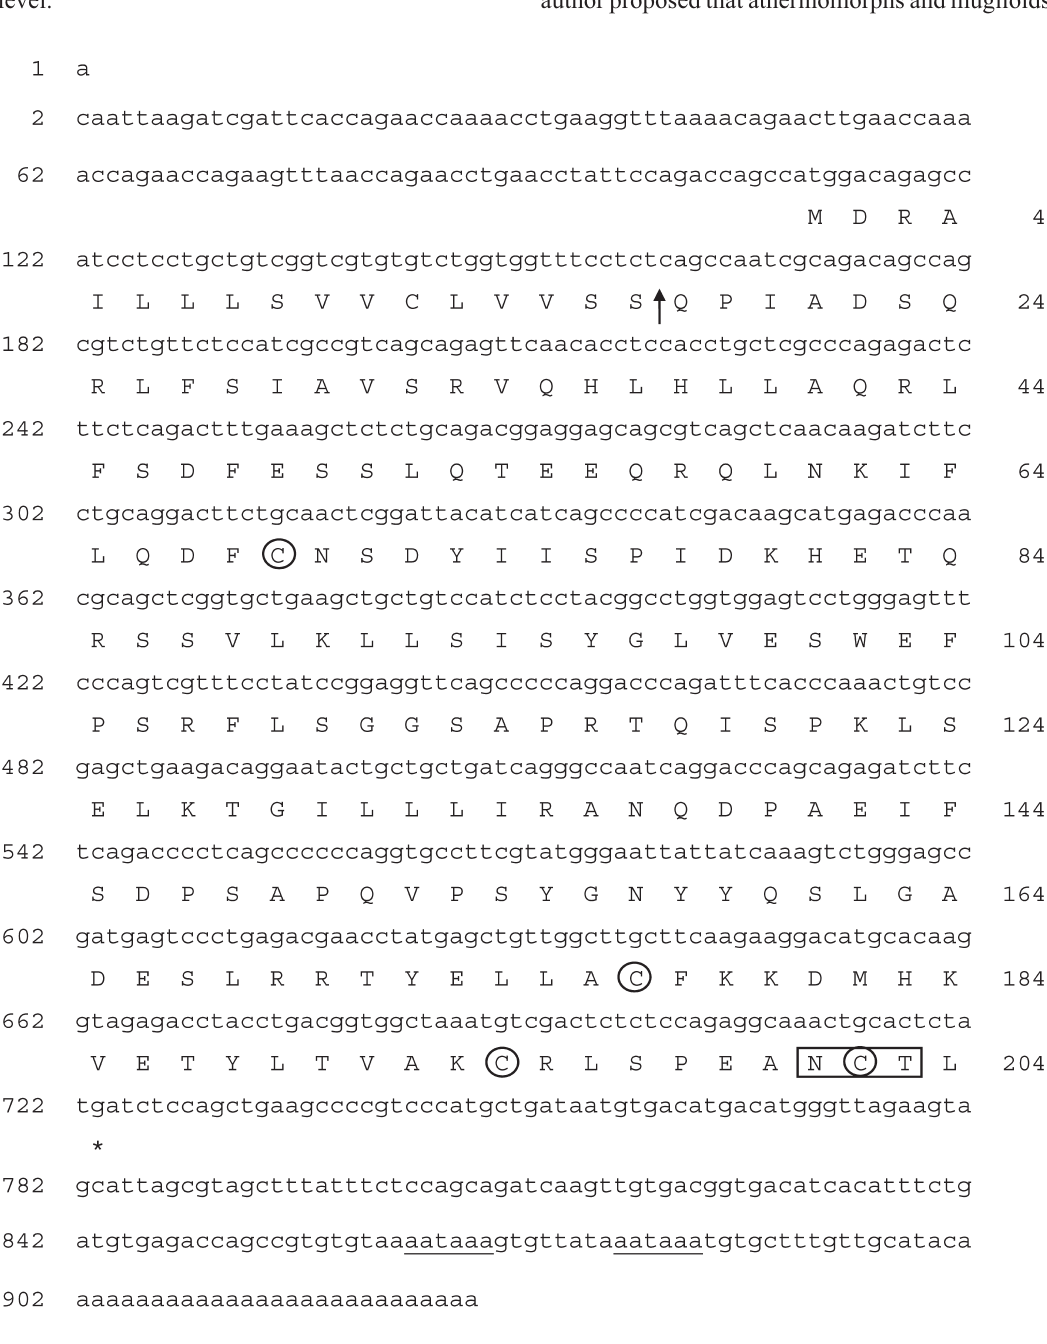
Figure1 -CompletenucleotidesequenceofthemarinesilversidefishGHcDNA(GenbankacessionAF236091)andthededucedaminoacidsequenceof the hormone. Nucleotides and amino acids are numbered on the left- and right-hand sides, respectively. The arrow indicates the possible site for signal peptide cleavage. The cysteine residues are circled. The asterisk indicates the termination codon. A potential N-glycosylation site (amino acids 201-203) is in the box, and the two polyadenylation signals are